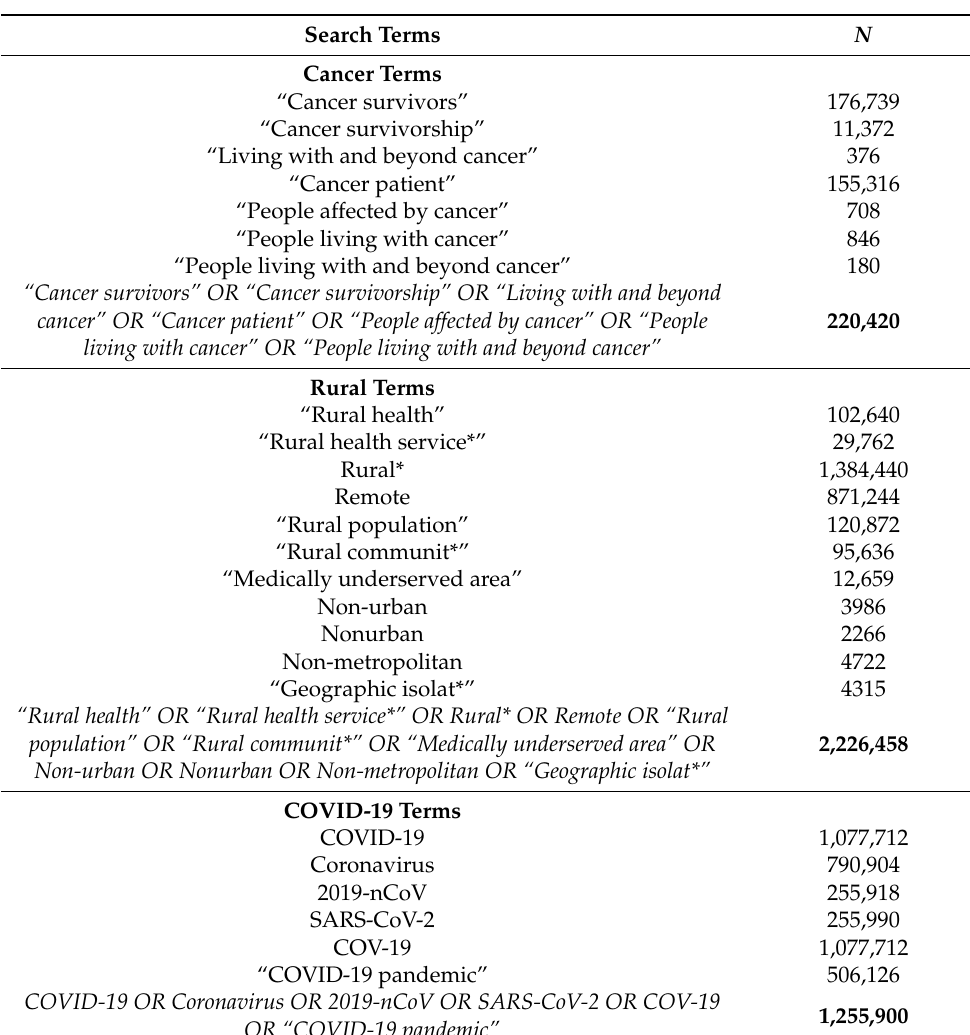
Table 1. Search Strategy for